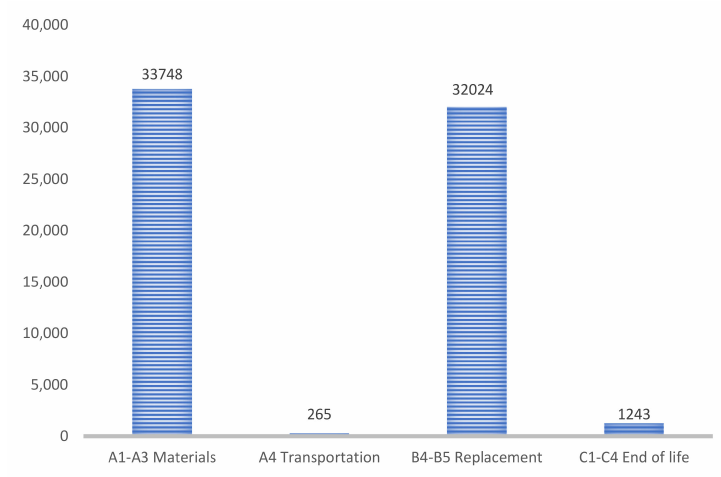
Figure 9. Scenario C: Global warming kg CO 2 -life-cycle stages.